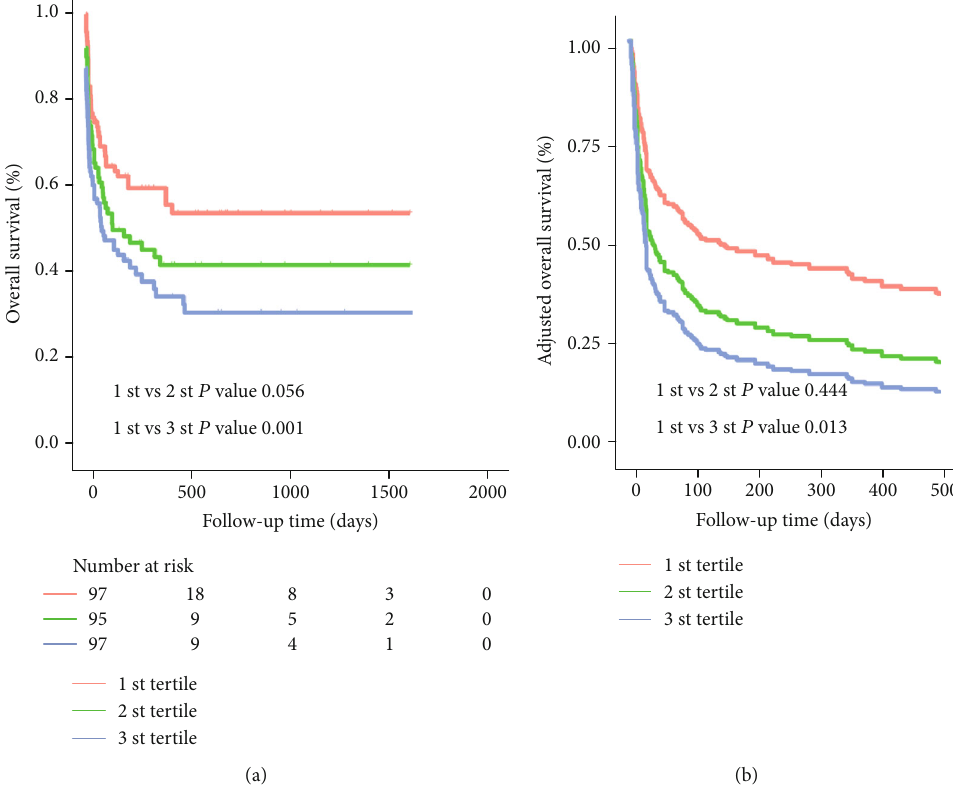
Figure 3: Survival curves in all sHLH patients according to De Ritis ratio tertiles. (a) Kaplan-Meier survival curves. (b) Adjusted survival curves: curves were adjusted for hepatomegaly, albumin (ALB), fi brinogen (FIB), EBV, ferritin, malignancy-associated HLH (MHLH), and treatment